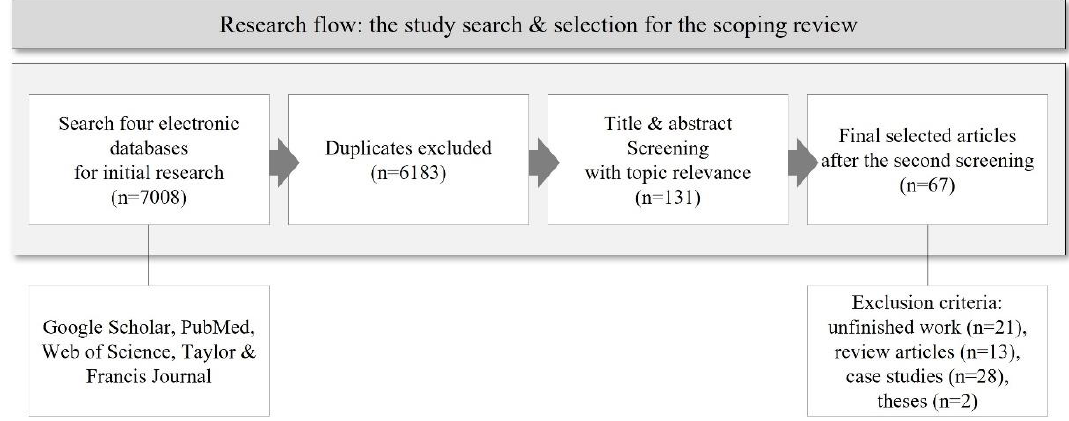
Figure 4. The flow of the research for the scoping review.